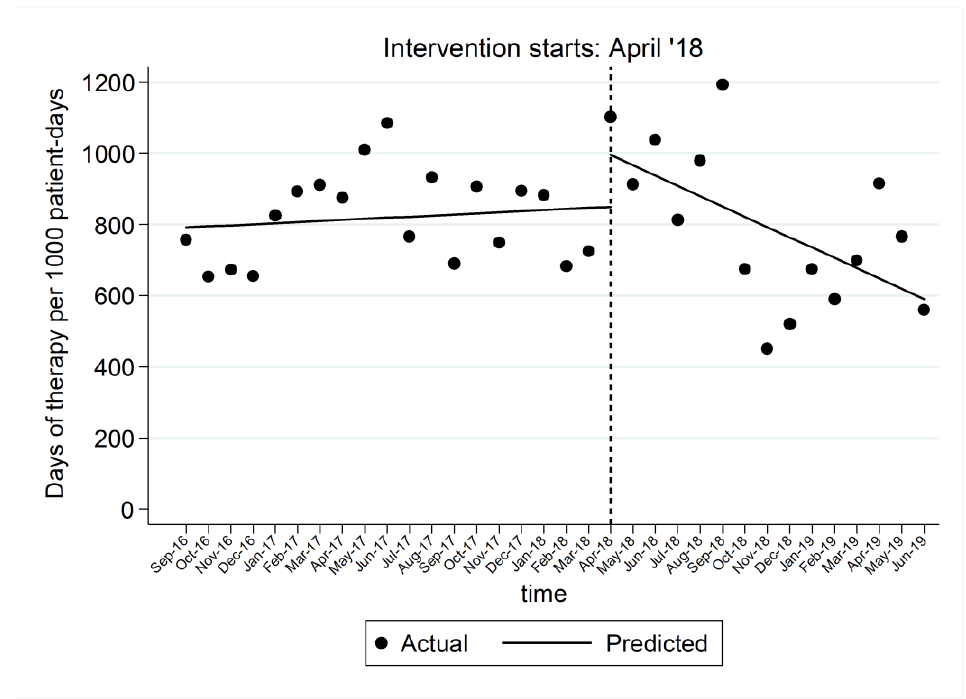
Figure 2. Interrupted time-series analysis of antibiotic use during the study in 13 NICUs in Greece. The period from September 2016 to March 2018 represents the pre-intervention period and April 2018 to June 2019 the post-intervention period.